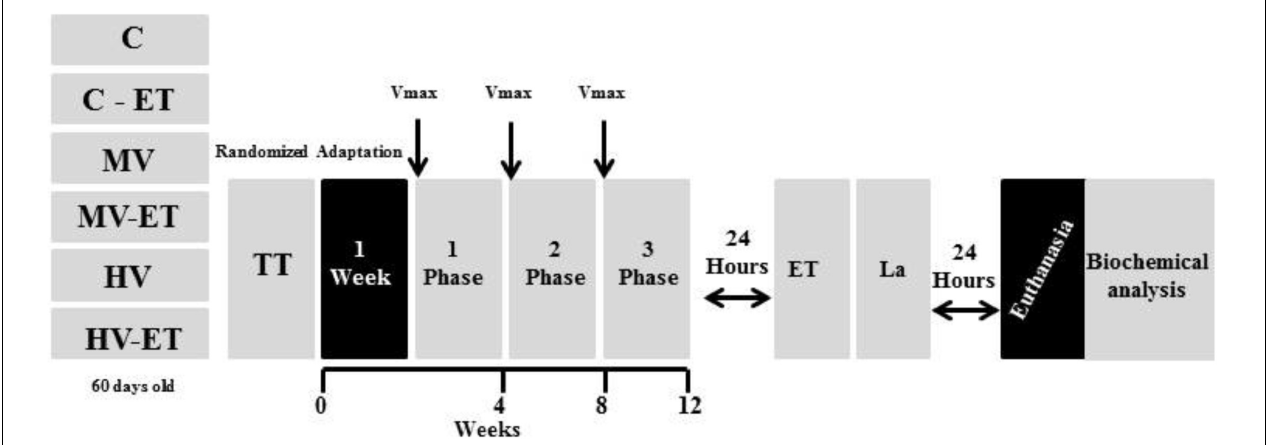
FIGURE 1 | Experimental protocol of aerobic exercise training under different volumes. Vmáx: Max speed test, ET, exhaustion test; TT, trainability test; La, lactate analysis. C, control group; C-ET, control group + exhaustion test; MV, moderate-volume group; MV-ET, moderate-volume + exhaustion test group; HV, high-volume group; HV-ET, high-volume + exhaustion test